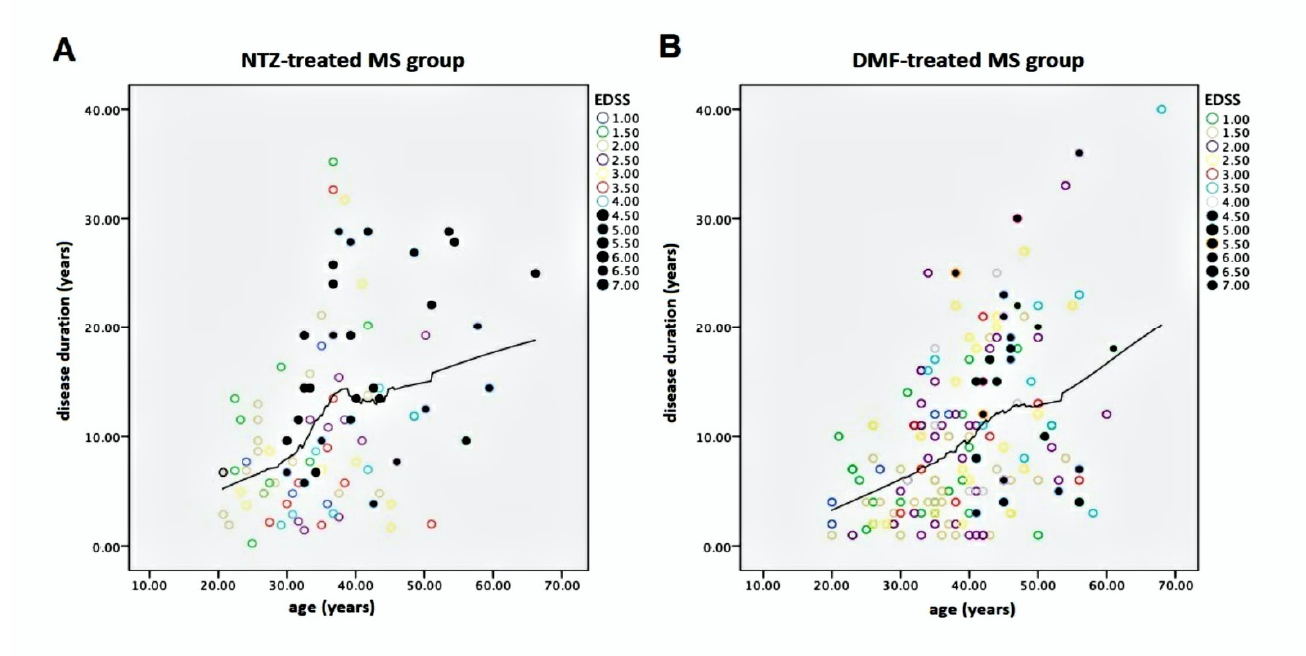
Figure 1. Graphical representations of correlation between age (years) and DD (years) with EDSS-labeled cases from the NTZ-treated ( A ) and DMF-treated ( B ) MS groups. Note, in bold, the EDSS cases ranging from 4.5 to 7.0 with a great slope corresponding to 39 to 40 years. EDSS—Expanded Disability Status Scale; NTZ—Natalizumab; DMF—Dimethyl fumarate; MS —Multiple